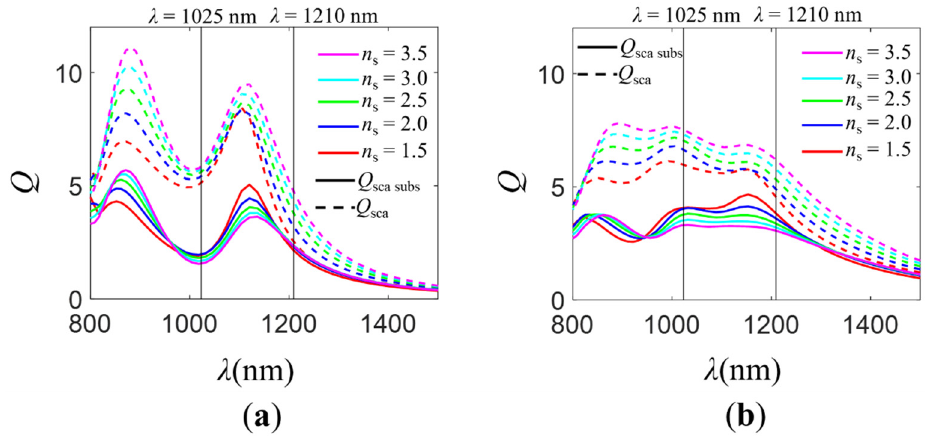
Figure 3. Total normalized scattering cross-section, Q sca (dashed line), and normalized scattering cross-section for radiation scattered into the substrate, Q sca subs (solid line), for different configurations of silicon NPs. ( a ) Isolated silicon NP of radius R = 150 nm. ( b ) Dimer of silicon NPs of radius R = 150 nm and gap distance d = 10 nm. The NPs were located on the surface of a monolayer substrate of known optical properties. The refractive index of the substrate was varied, n s ∈ [1.5–3.5]. The structures were illuminated by an unpolarized plane wave propagating normally to the surface of the substrate. Vertical black lines correspond to the wavelengths where the zero-backward ( λ = 1210 nm) and near zero-forward/“near zero-backward” ( λ = 1025 nm) conditions were attained.